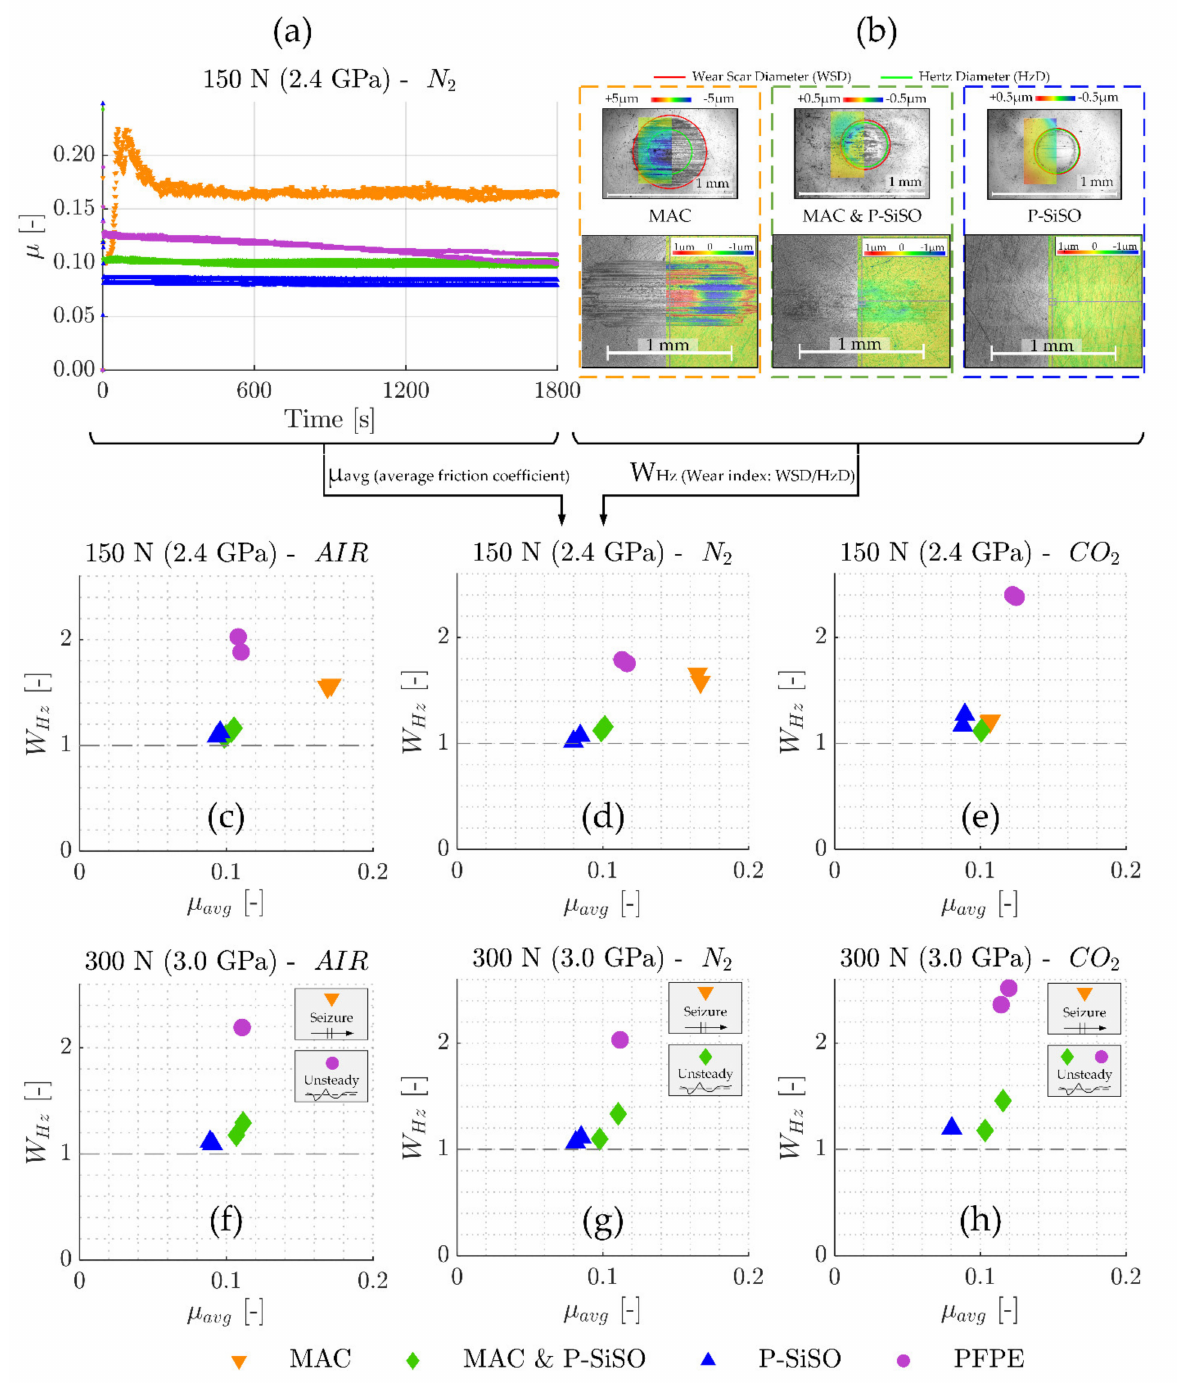
Figure 5. ( a ) Friction traces recorded for neat MAC, ‘MAC &P-SiSO’, neat P-SiSO, and neat PFPE at conditions of {150 N/2.4 GPa/N 2 }. ( b ) Pairs of ball and disc wear scars for neat MAC, ‘MAC &P-SiSO’, and neat P-SiSO, as seen with optical 3D-profilometer (3DP). Color-coded topography data is overlaid on intensity charts to provide representative images of the morphology and severity of wear encountered on both ball (upper part of image) and disc (lower part). ( c – h ) Average wear index (W Hz ) plotted against the average friction coefficient ( µ avg ) at 150 and 300 N load in AIR, N 2 , and CO 2